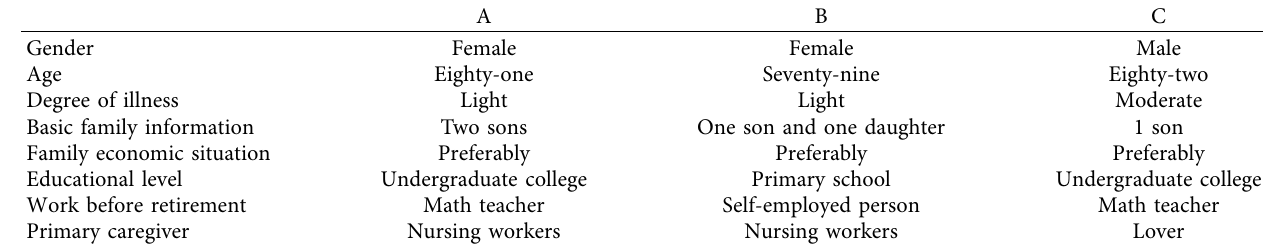
Table 1: Basic information of the